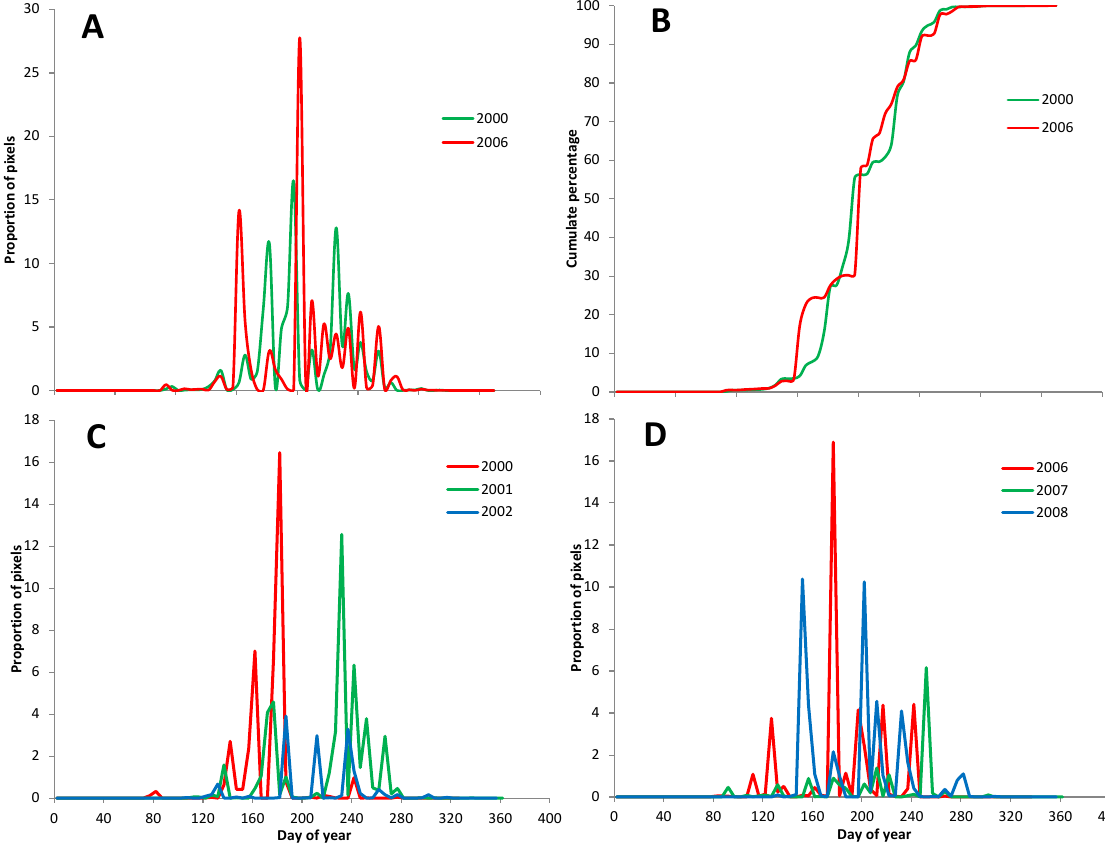
Figure 7. Distributions of dates when good quality data were collected that went into the 2000 and 2006 Chicago NDVI composites. ( A ) Date distribution without year differentiation; ( B ) cumulative curves of A; ( C ) date distribution with year differentiation in the 2000 composite; and ( D ) date distribution with year differentiation in the 2006